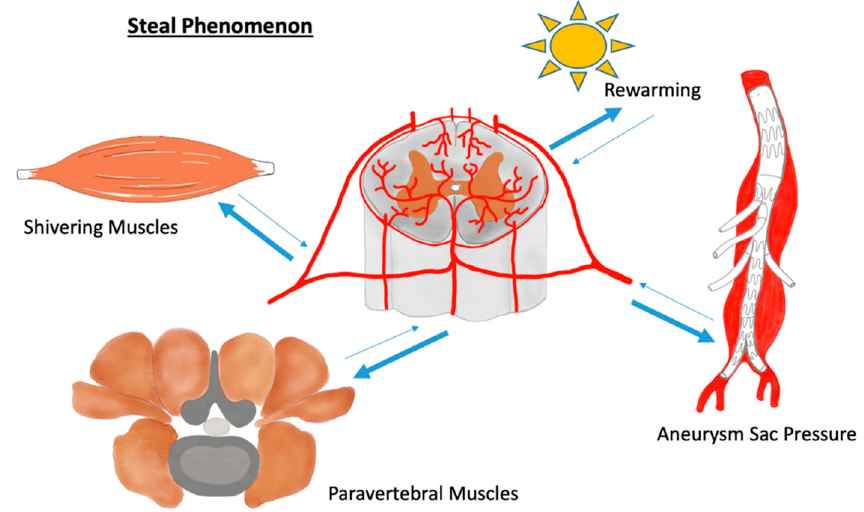
Figure 1. During a steal phenomenon blood becomes redistributed endangering spinal cord blood supply by hypoperfusion.